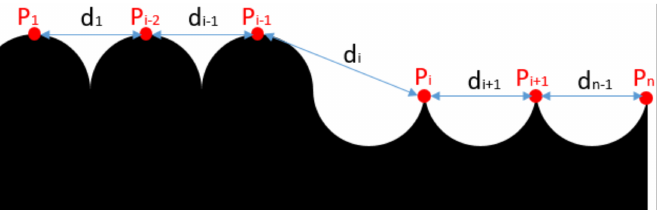
Figure 11. Projection diagram of rope arrangement without rope arrangement fault. “di” is different from the others, while the average of the others is 2 × r.